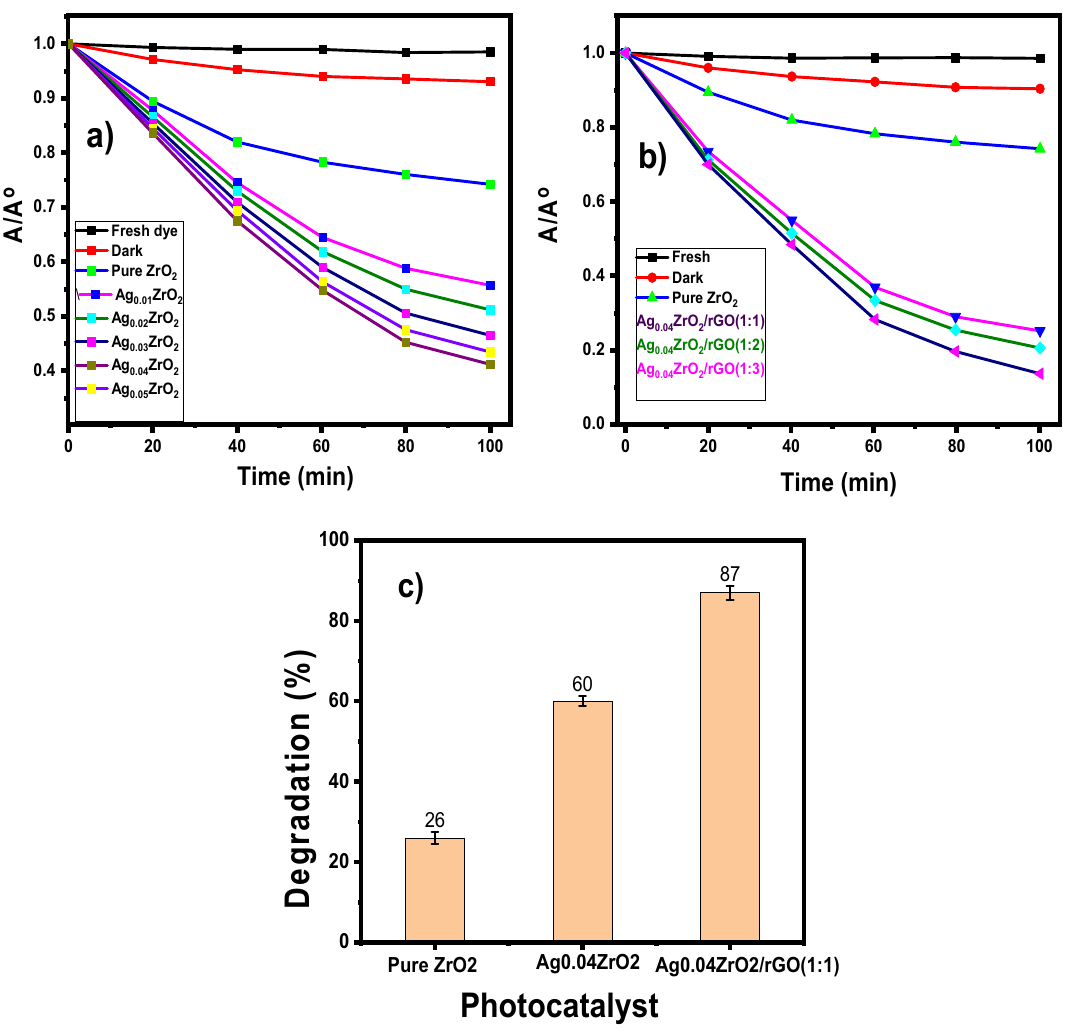
Figure 6. Comparison of degradation of MO ( a ) pure ZrO 2 and Ag x ZrO 2 (x = 0.01–0.05), ( b ) pure ZrO 2 and Ag